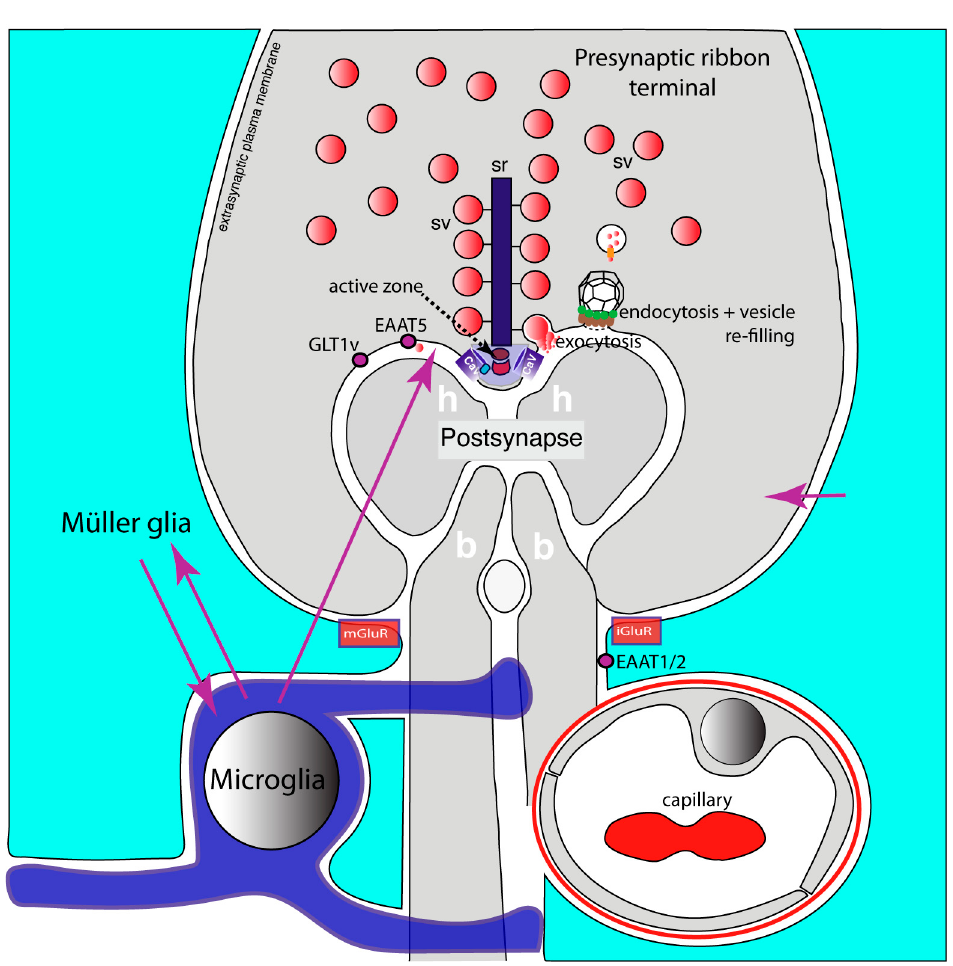
Figure 2. Glutamatergic retinal ribbon synapses. It schematically depicts a glutamatergic ribbon synapse of the retina. A photoreceptor ribbon synapse is shown. The functional and molecular com- position of the presynaptic ribbon terminal is like that of the brain synapse shown in Figure 1. How- ever, the presynaptic terminals of ribbon synapses possess eponymous synaptic ribbons that pro- vide the active zone with additional synaptic vesicles to enable continuous synaptic transmission at this synapse. The active zone is the site at which exocytosis of synaptic vesicles occurs close to volt- age-gated L-type Cav-channels. Endocytosis of fused vesicle membrane occurs in the periactive zone, followed by a refilling process of endocytosed vesicles with glutamate. The postsynapse is composed of the dendrites of horizontal and bipolar cells. The postsynaptic dendrites contain iono- tropic and metabotropic glutamate receptors (not shown). Müller glial cells form perisynaptic pro- cesses that are enriched in glutamate transporters (EAAT1, EAAT2). The presynaptic terminal con- tains additional glutamate transporters (GLT1v, EAAT5) in the periactive zone. Retinal ramified microglial cells frequently contact synapses and likely communicate with Müller glial cells (magenta arrows). Retinal ribbon synapses are very sensitive to neuroinflammatory changes. Neuroinflam- matory changes strongly affect presynaptic terminal functions (for details, see text). Active zone composition, presynaptic Ca 2+ homeostasis and exo- and endocytic vesicle cycling in these synapses are disturbed in EAE. The underlying mechanisms are not yet fully elucidated but might involve simar pathways as described for brain synapses (see text). Arrows in magenta indicate possible in- teractions between Müller cells, microglia and the photoreceptor synapse. Abbreviations: sv, syn- aptic vesicles; sr, synaptic ribbon; Cav, voltage-gated Ca 2+ -channel; mGluR, metabotropic glutamate receptor at Müller glial cells; iGluR, ionotropic glutamate receptor at Müller glial cells; h, horizontal cell postsynaptic dendrite; b, bipolar cell postsynaptic dendrite; GLT1v, glutamate transporter 1 splice variant; EAAT1/2, excitatory amino acid transporter 1/2. Of note, glutamate transporters (GluTs) can also revert the transport direction of glu- tamate and secrete glutamate. This can occur during pathological conditions/diseases. The